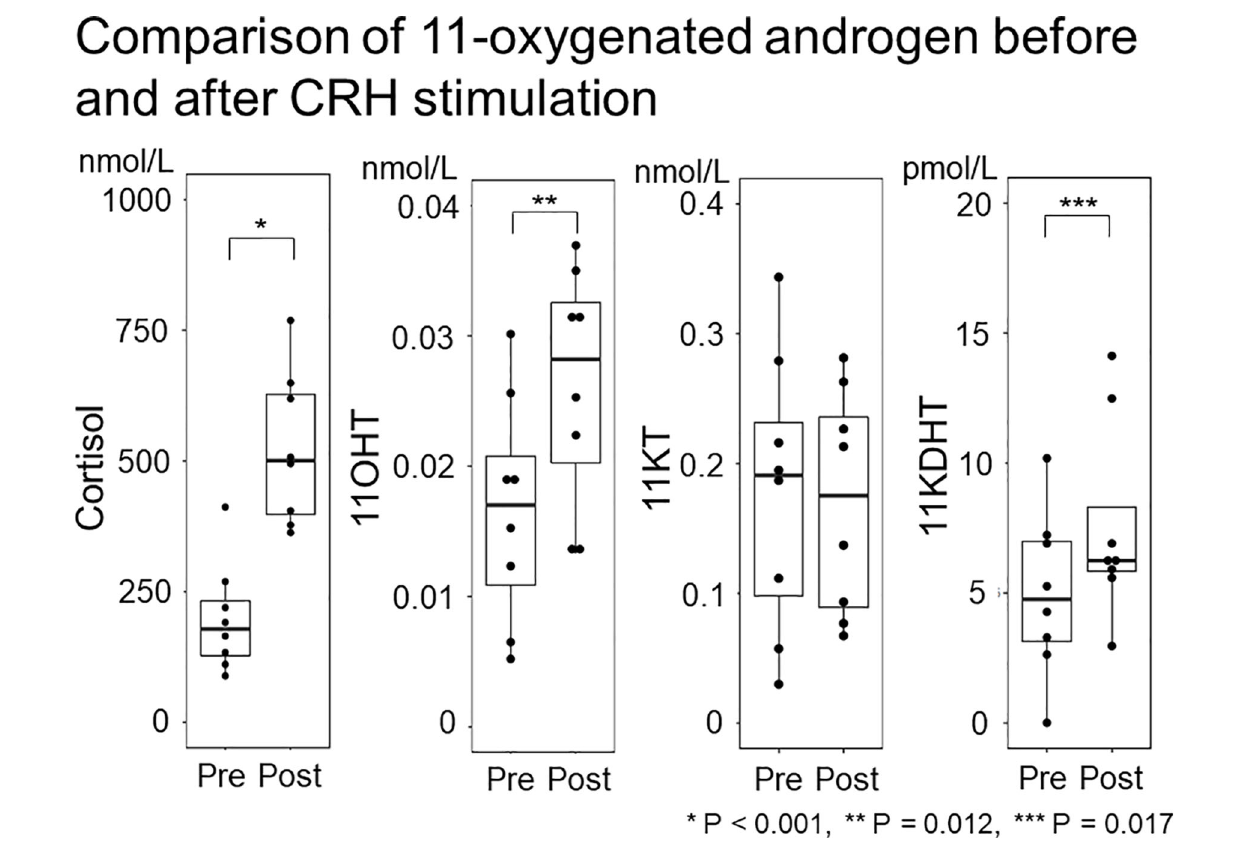
FIGURE 4 Comparison of 11-oxygenated androgen before and after CRH stimulation. The 11-oxygenated androgen values before and after CRH stimulation were compared. Serum cortisol and 11OHT were higher after CRH stimulation, but 11KT did not differ before or after ACTH stimulation.